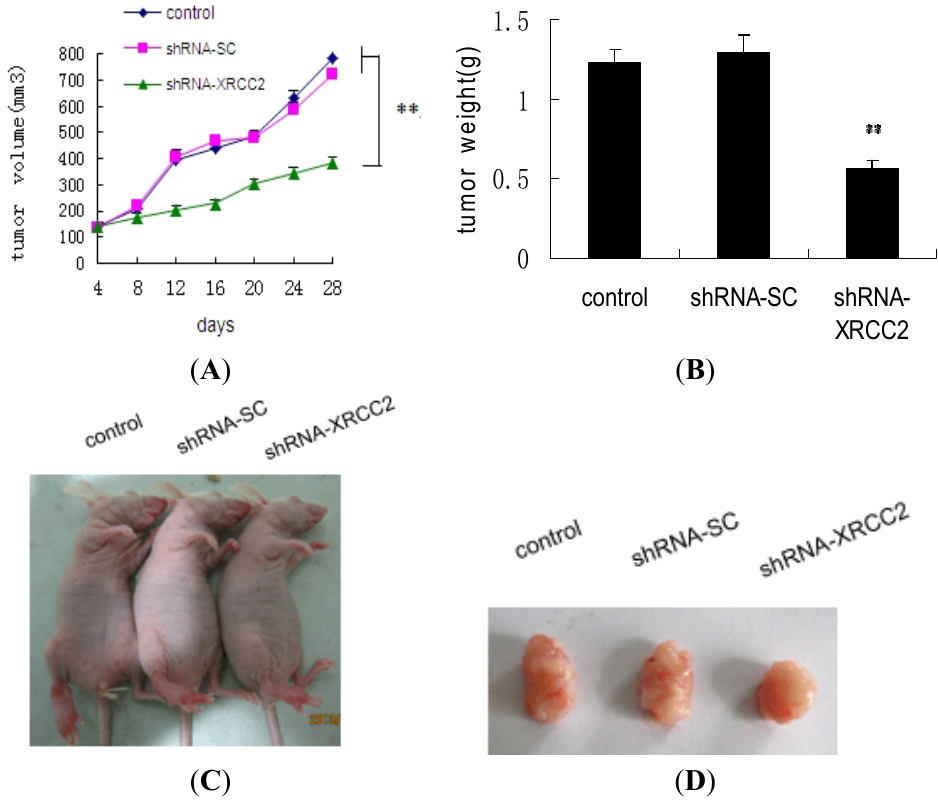
Figure 7. Knockdown of XRCC2 decreased tumor growth in nude mice. ( A ) Tumor growth curve; ( B ) Tumor weight after mice were sacrificed; ( C ) Ectopic T84 xenografts in nude mice; and ( D ) Photograph of the dissected tumors. The effect of shRNA-XRCC2 on tumorigenicity was examined in nude mice. Mice were treated with either shRNA-XRCC2 or shRNA-SC. Radiation treatment (2 Gy) was given once every other day when tumor volume reached 100 mm 3 in a total of 10 days. The tumor volume and tumor weight was examined for 28 days after exposure to radiation. The values are presented as the mean ± SD ( n = 10). ** p < 0.01 compared with the control group.